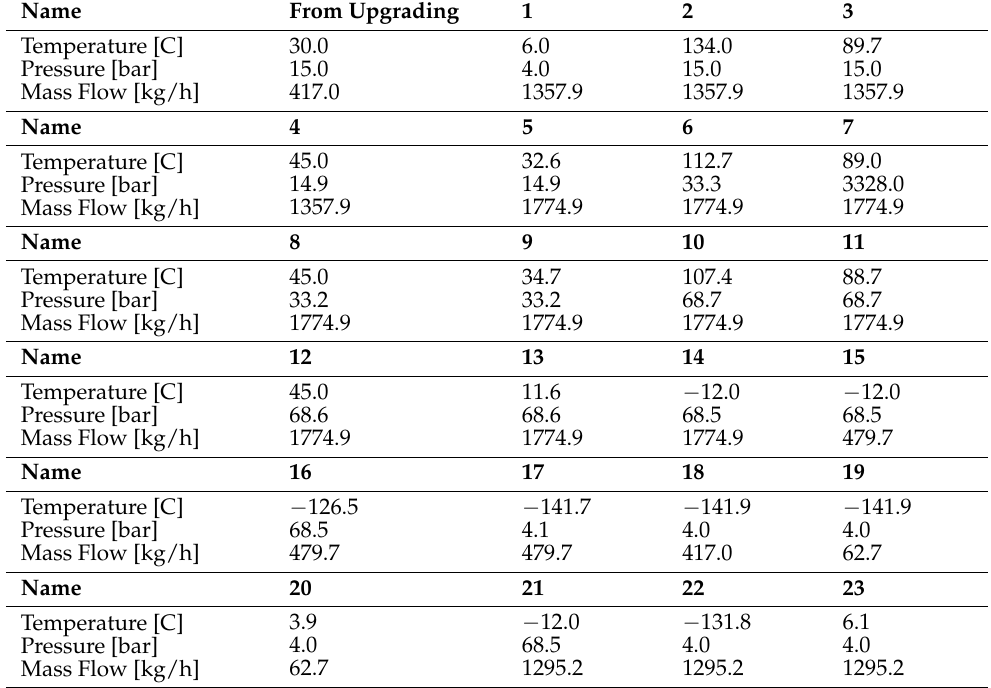
Table A13. States of the biomethane flows in AC-3.